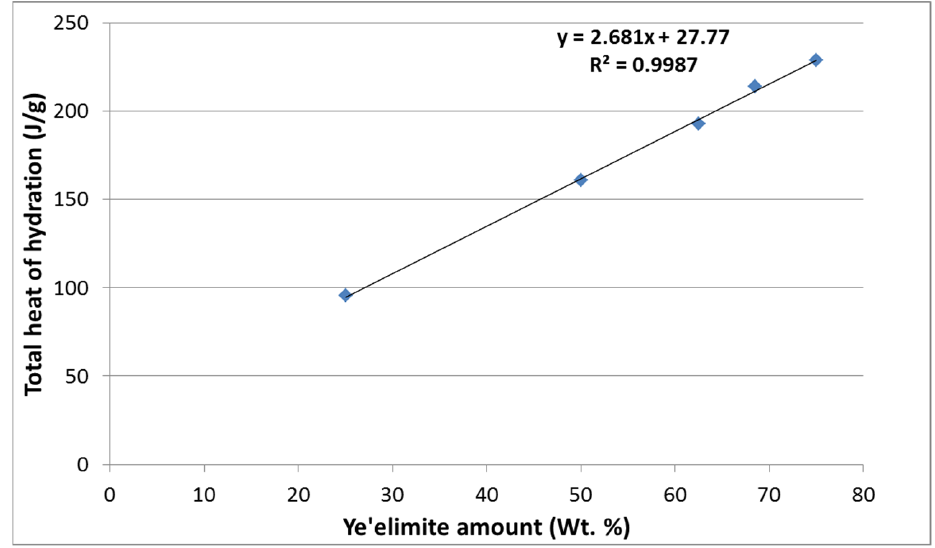
Figure 5. Total heat release at 24 h as a function of the ye’elimite content in the CSA clinker.